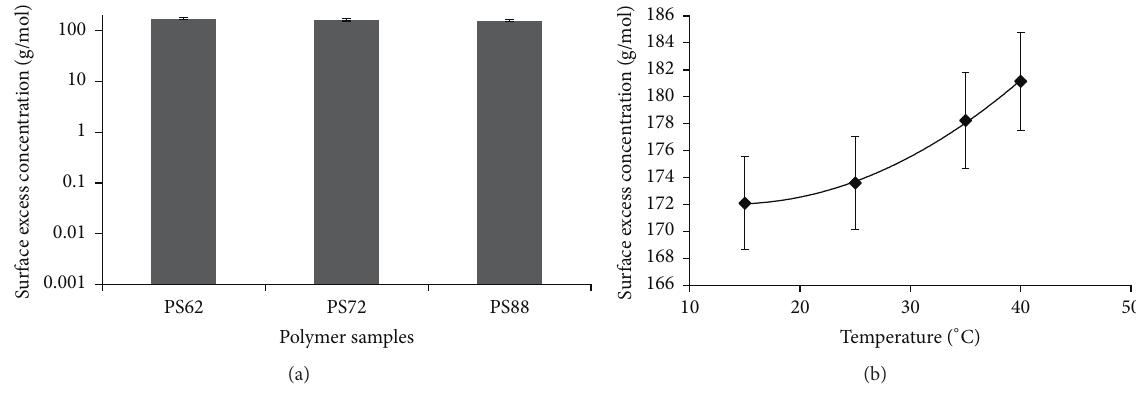
Figure 8: Surface excess concentration of polymer samples as a function of (a) polymer nature and (b) temperature for polymer PS62.